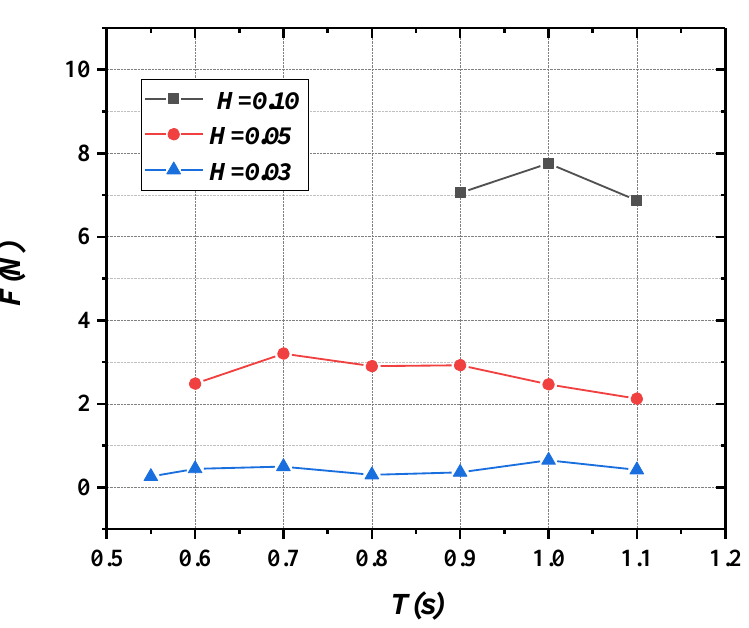
Figure 33. Variations of 4# mooring force.